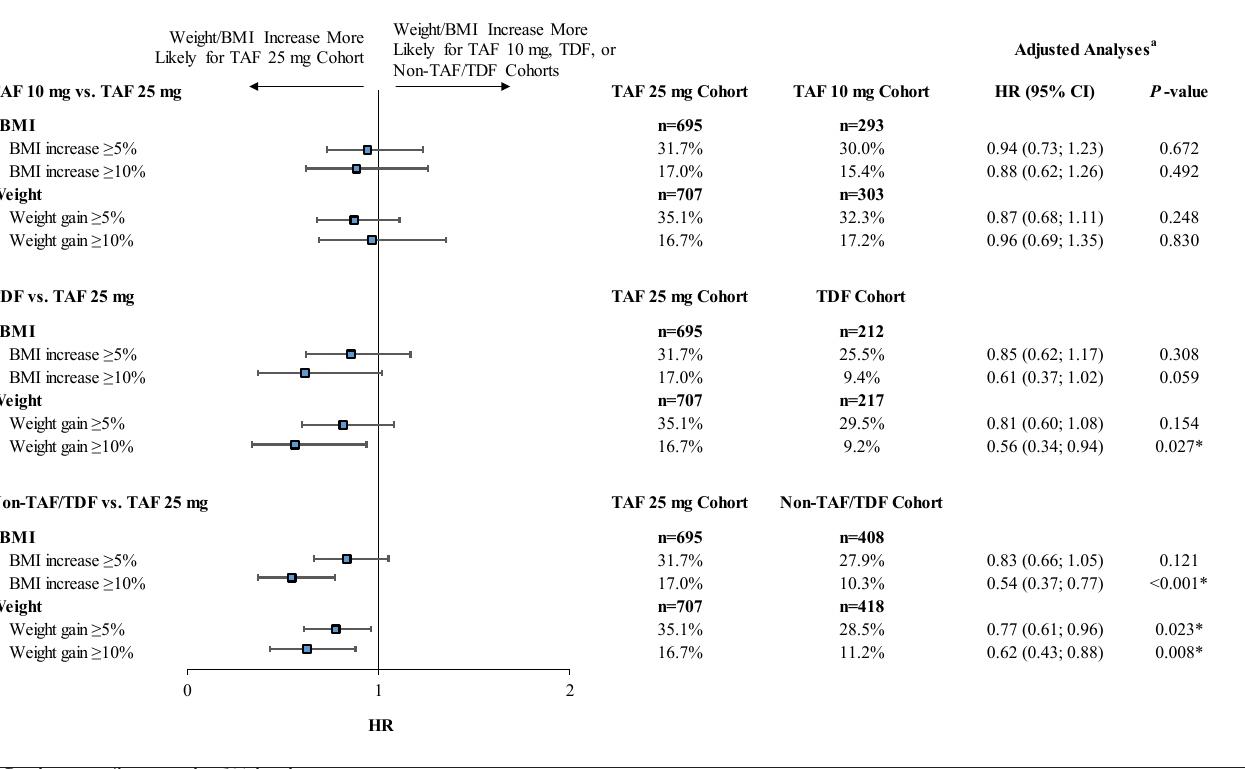
* P value significant at the 5%